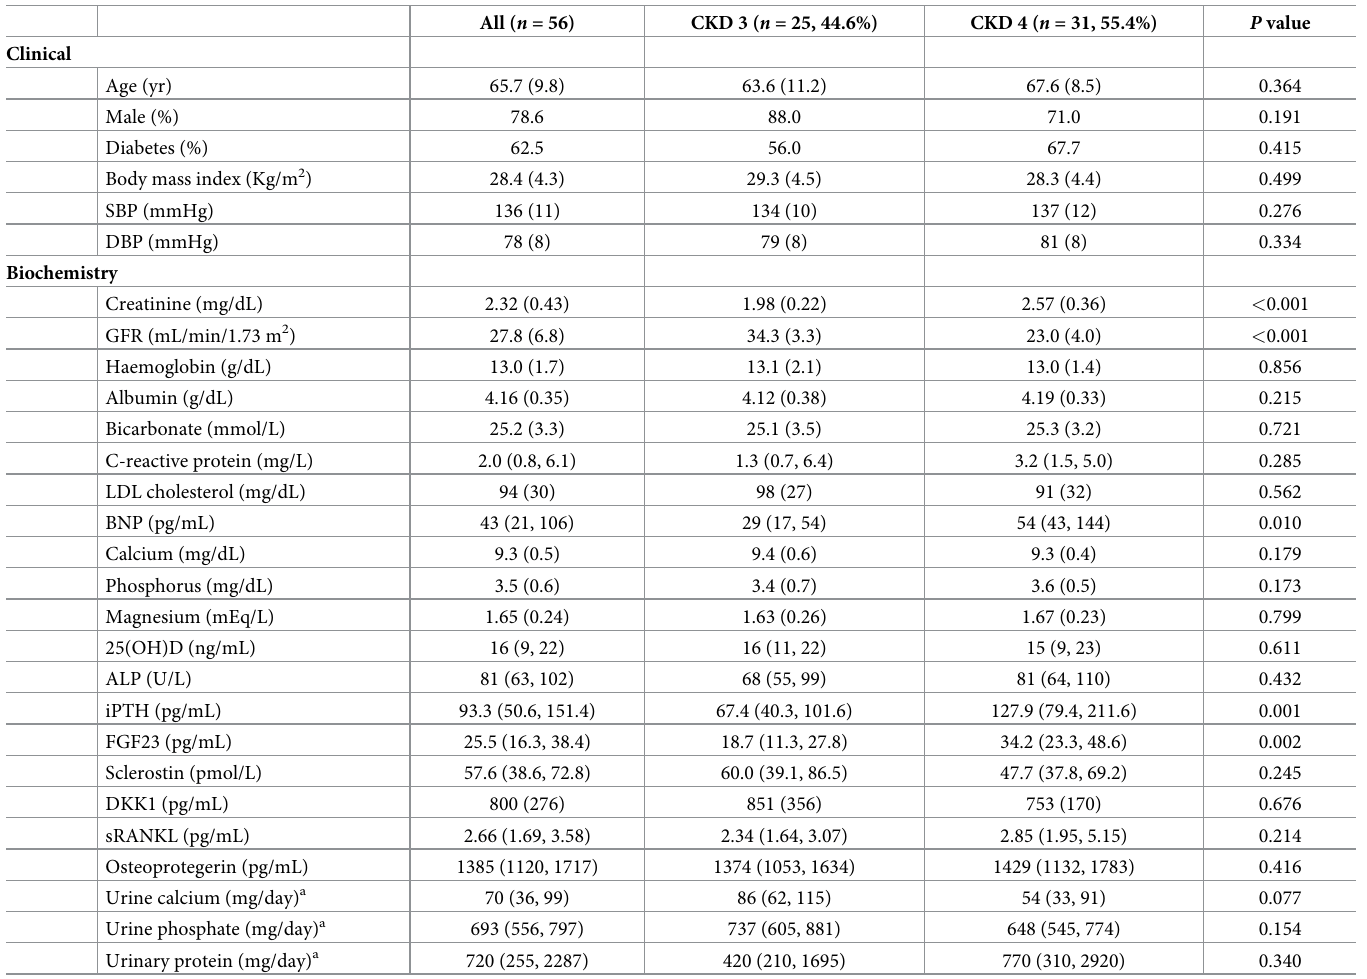
Table 1. Demographic, clinical and laboratory characteristics of the study population according to CKD stage. All ( n = 56) CKD 3 ( n = 25,